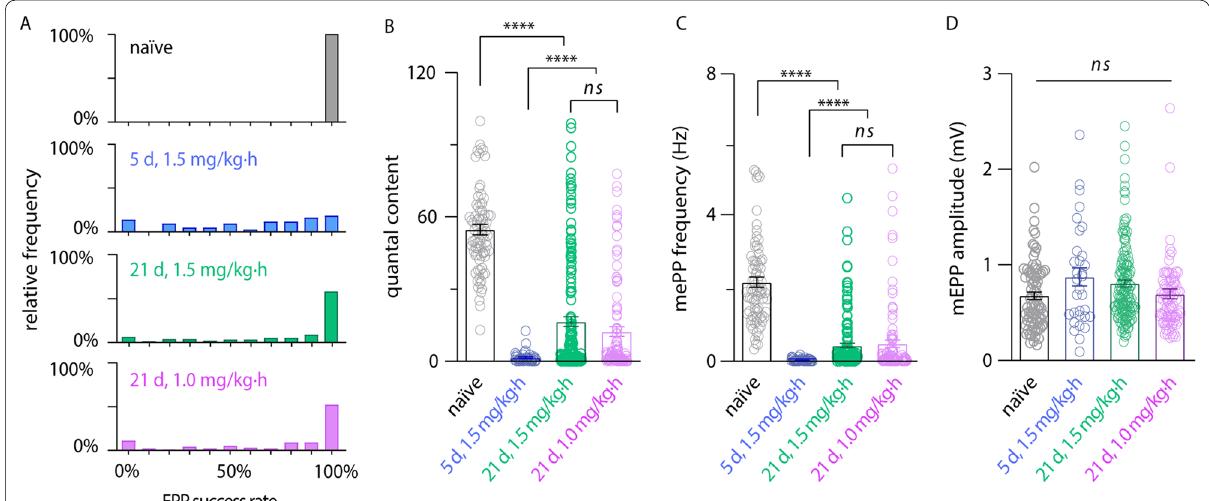
Fig. 4 Time‑dependent recovery of diaphragm endplate potentials (EPPs) in 3,4‑DAP infused intoxicated rats. Diaphragm endplate success rates, quantal content (QC) and miniature EPPs (mEPPs) were compared among naïve rats (black); rats intoxicated with 0.44 ng/kg BoNT/A, infused with 3,4‑DAP from 1 to 14 d at 1.0 mg/kg∙h (green) or 1.5 mg/kg∙h (pink) and euthanized at 21 d; or rats intoxicated with 0.44 ng/kg BoNT/A, infused with 1.5 mg/kg∙h 3,4‑DAP from 1 to 5 d and euthanized (blue). A Histogram of EPP success rates. During each endplate recording, phrenic nerves were stimulated with a train of 10 impulses at 0.2 Hz and the percentage of impulses that produced EPPs were determined. B – E Mean scatter plots for ( B ) Quantal content, ( C ) mEPP frequencies and ( D ) mEPP amplitudes. For B and D , each circle represents average responses of 10 stimulations in one endplate. For C , each circle represents mEPP frequencies measured in one endplate. **** p < 0.0001, ns indicates